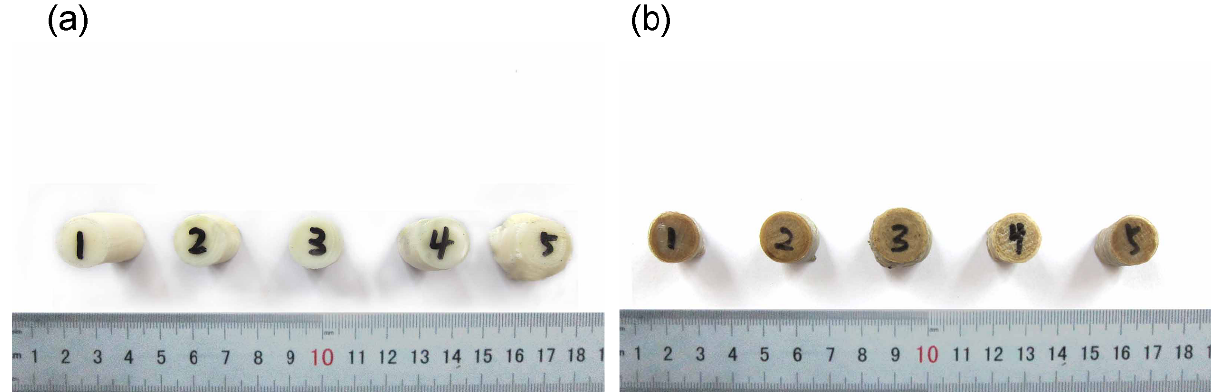
Figure 7. Fractured compressive samples. ( a ) acrylonitrile butadiene styrene (ABS); ( b ) polyether-ether-ketone (PEEK).